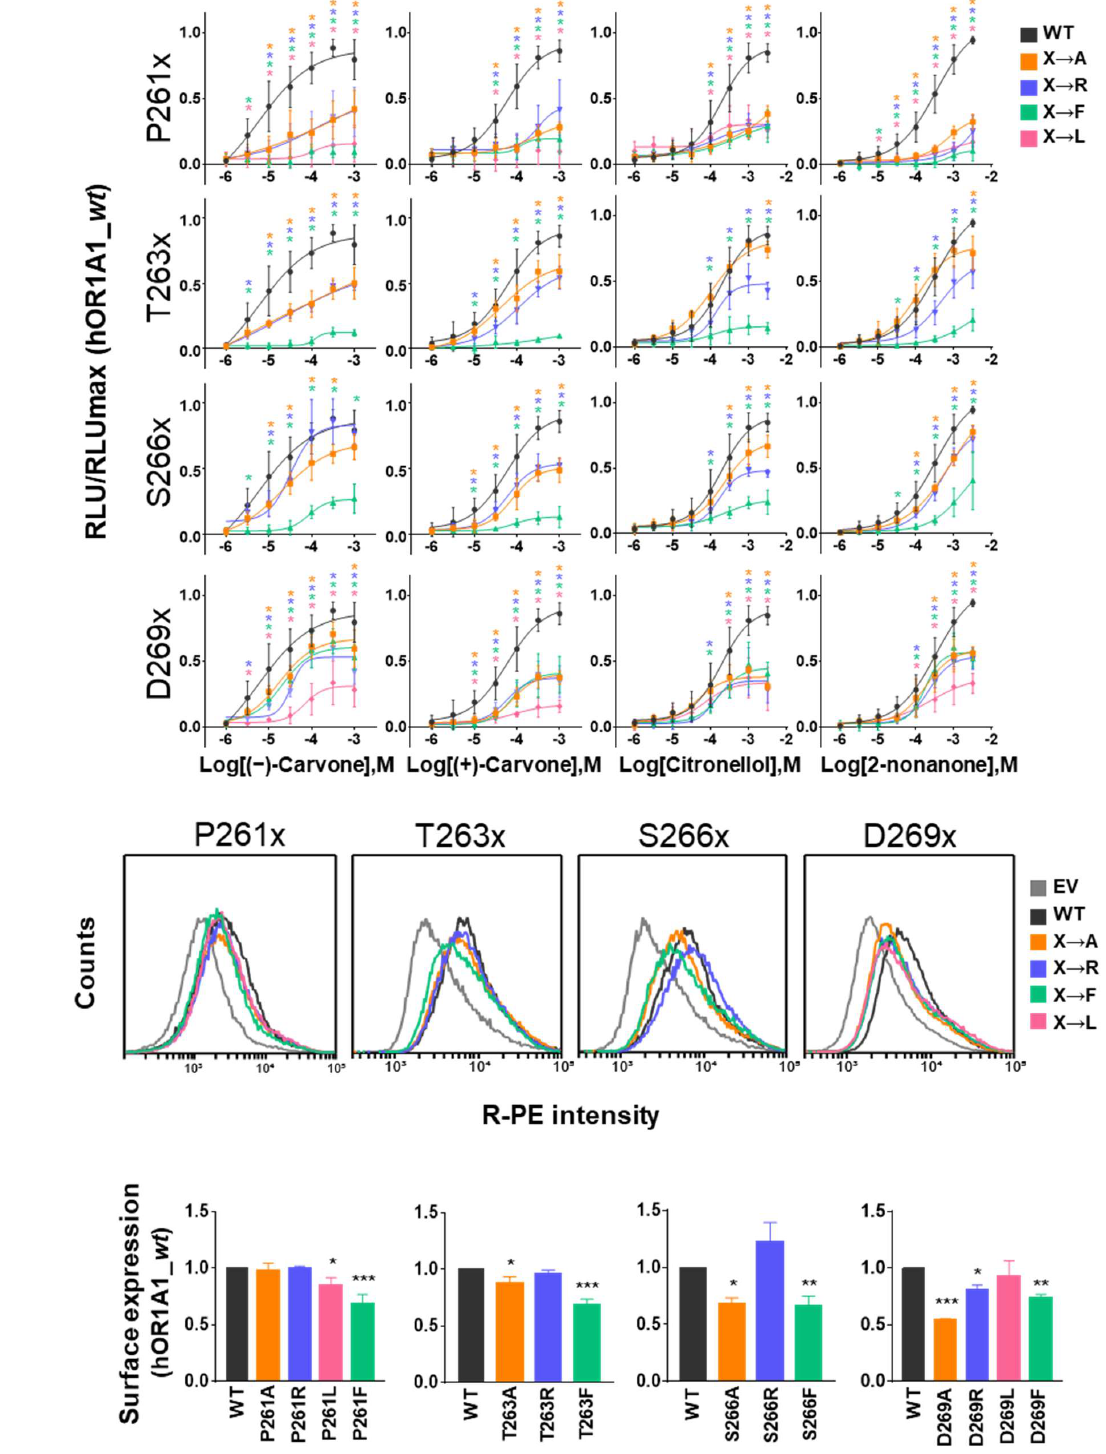
Figure 4. In vitro data of hOR1A1 and mutant ORs. ( a ) In vitro dose–response curves of four ligands ( − )-carvone, (+)-carvone, citronellol, and 2-nonanone towards wt hOR1A1 and mutant ORs at positions P261, T263, S266, and D269. (*) indicates the response value is significantly different compared to wt hOR1A1 (one-way ANOVA, followed by a Dunnett test; * p < 0.05). (RLU = relative luminescence unit) ( b ) The fluorescence intensity of the R-phycoerythrin (R-PE) signal of wt hOR1A1 and mutant ORs at positions P261, T263, S266, and D269. ( c ) Normalized graph of cell-surface expression of ECL3 mutant ORs against wt hOR1A1 (one-way ANOVA, followed by a Dunnett test; * p < 0.05, ** p < 0.01, and *** p <